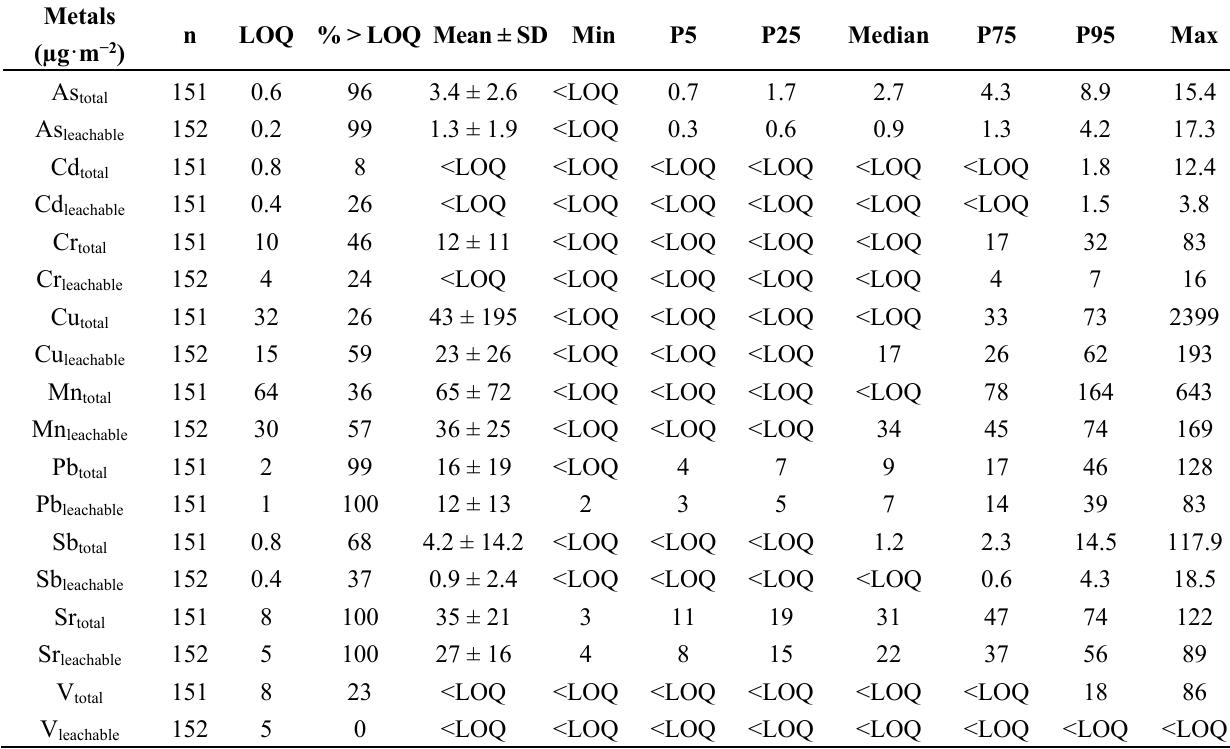
Table 4. Metal loadings (µg·m − 2 ) in settled dust from